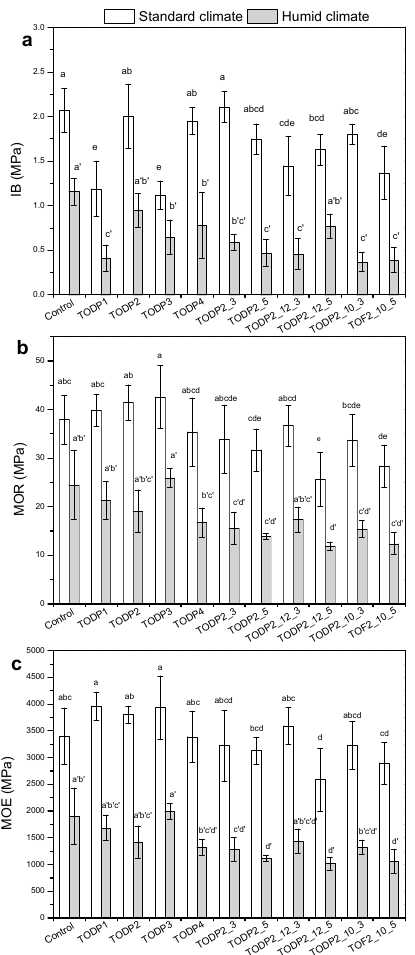
Figure 4. ( a ) Internal bond strength (IB), ( b ) modulus of rupture (MOR) and ( c ) modulus of elasticity (MOE) of the HDF panels under standard and humid climate conditions. Values labeled with a di ff erent letter are statistically di ff erent (ANOVA and Tukey’s HSD test) at an error probability of α = 0.05. Error bars represent standard